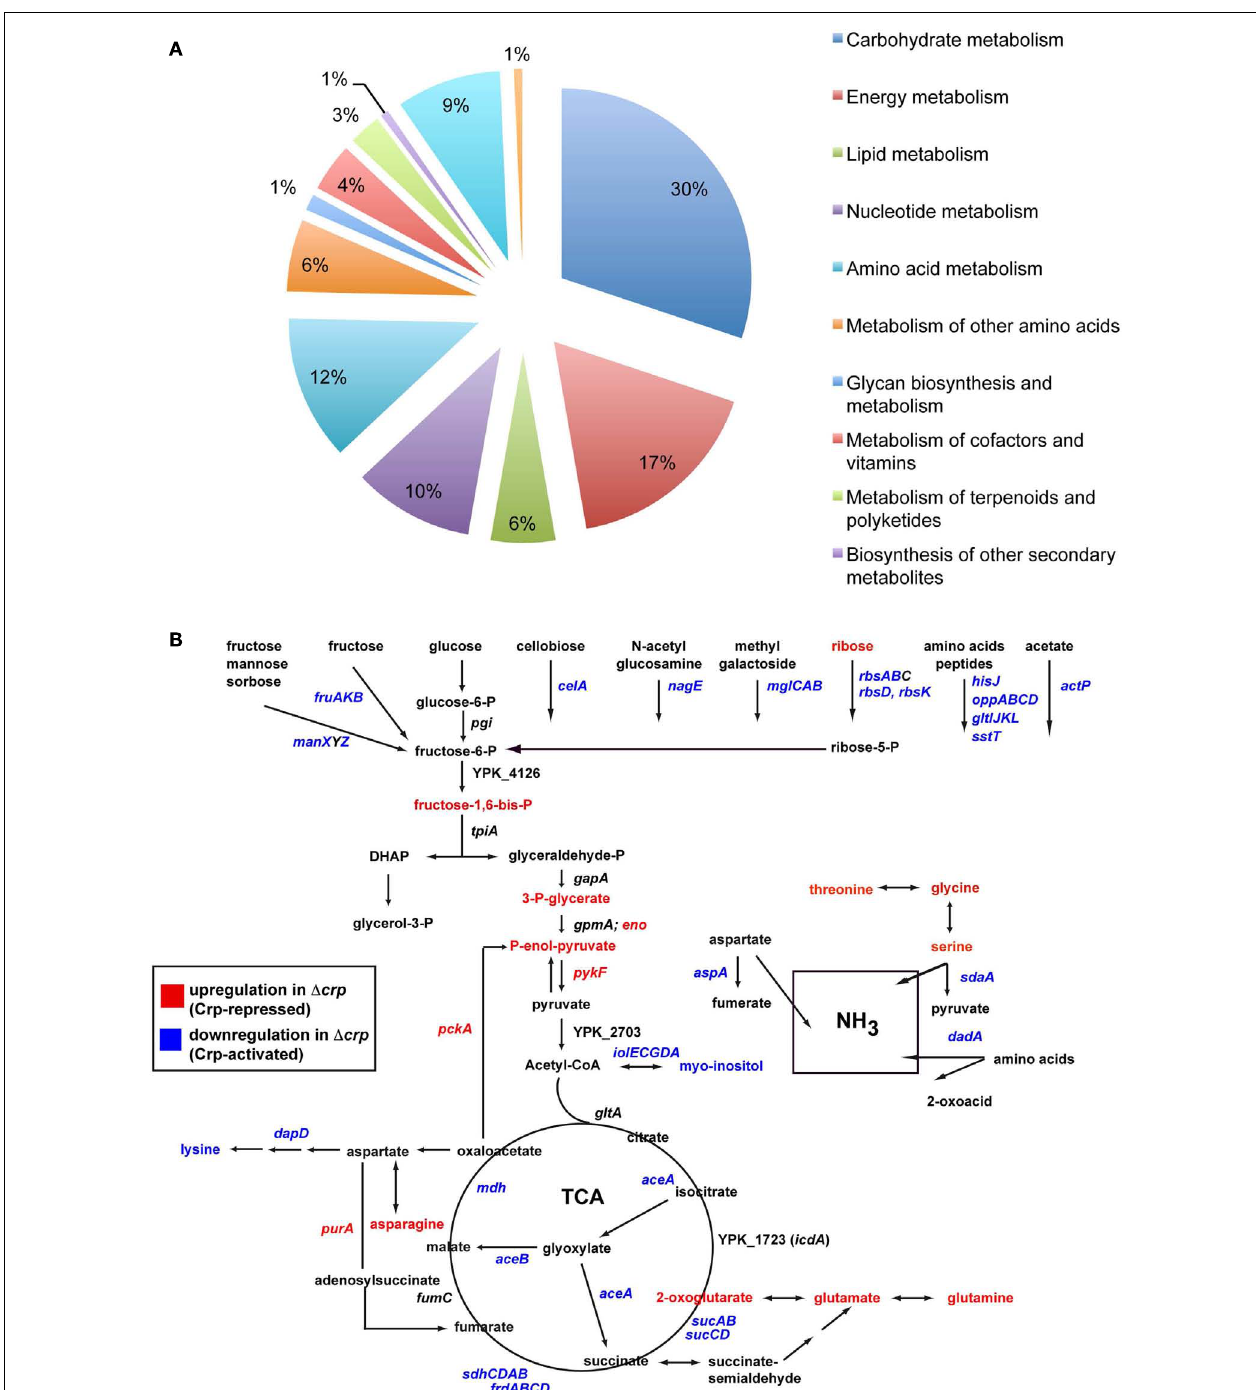
Supplementary Material). Genes showing overall fold-changes ≥ 1.8 are included in the displayed diagram of gene classes. (B) Central carbon metabolism in Y. pseudotuberculosis . Significant alterations in the metabolic and transcriptomic pattern between the wildtype and the crp mutant are indicated. An increase of a metabolite in the crp mutant is indicated by showing the metabolite in red (Crp-repressed), whereas a decreased metabolite is displayed in blue (Crp-activated). Accordingly, upregulated genes in the crp mutant are indicated in red (Crp-repressed), downregulated genes are given in blue